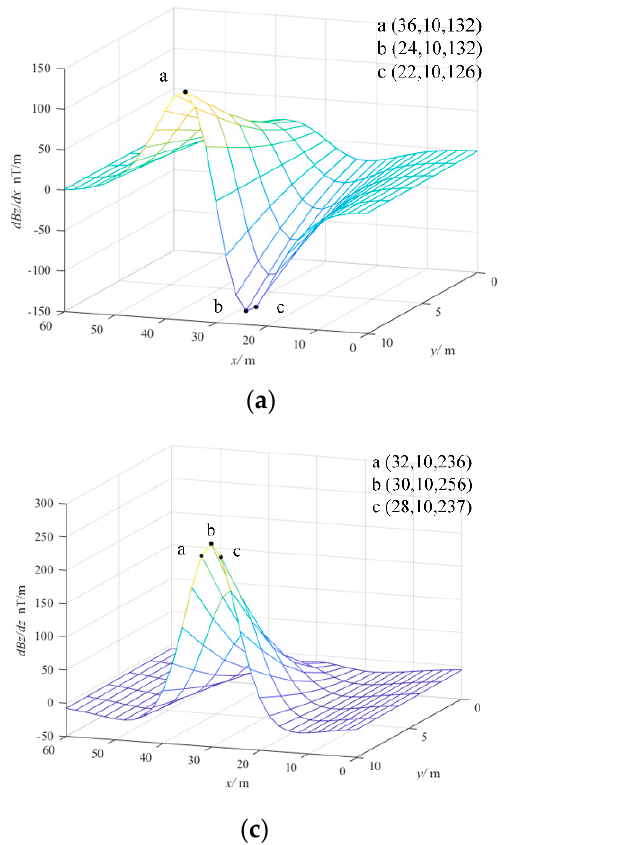
Figure 3. The comparison between LMM and MFG.